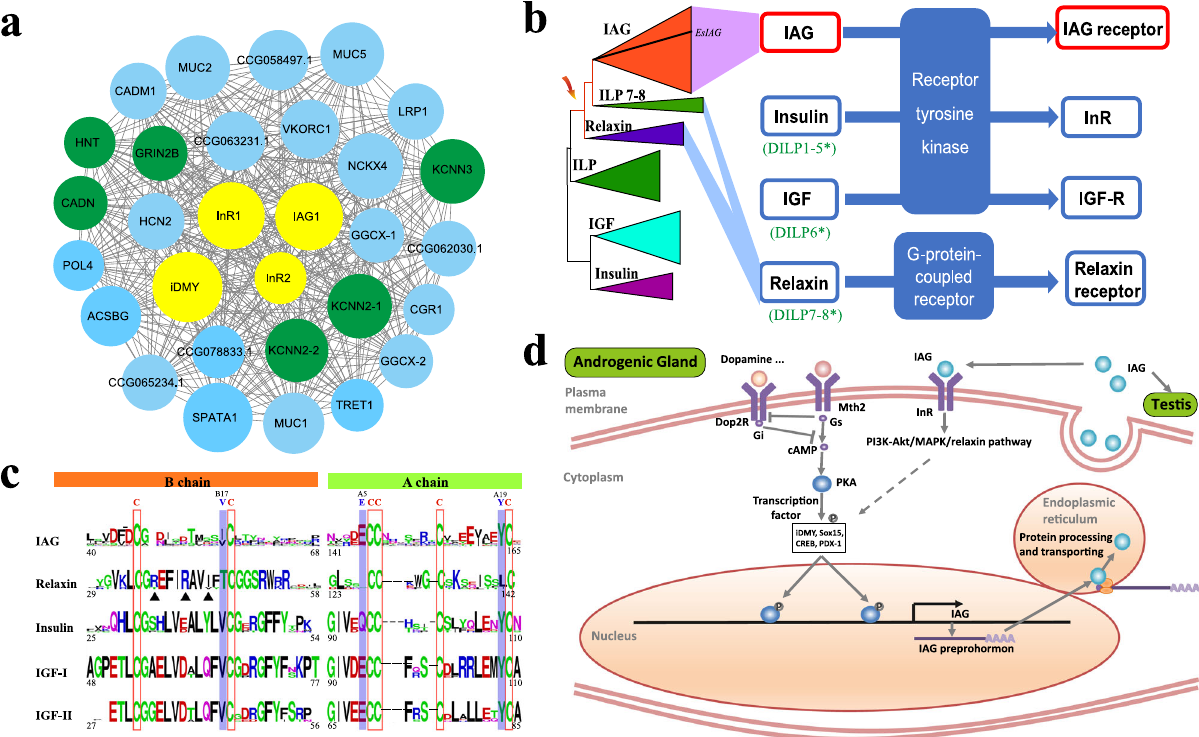
Fig. 5 The molecular regulation of AG. a The co-expression network of the AG-related module (midnightblue, see Supplementary Data 13). The midnightblue module contains 216 genes, of which 30 genes with the highest intramodular connectivity are chosen for network display. IAG-related receptors and transcription factors are labeled in yellow. The neuron or axon-related genes are labeled in green. b Insulin-like peptides and their receptors. The insulin-like peptide (ILP) is subdivided into IAG, insulins, insulin-like growth factors (IGFs) and relaxins on the basis of primary structure, processing and receptor binding preferences. c Conserved sites of crustacean IAG, and vertebrate relaxin, insulin and IGF-1 and IGF-II. The key functional sites for receptor binding are indicated by triangles. The amino acid numbers are with reference to IAG of Litopenaeus vannamei and other insulin members of human 125 . d The predicted synthesis and secretion pathway of IAG. Mth2 methuselah, PKA protein kinase A, Dop2R dopamine D2-like receptor, Gs guanine nucleotide-binding protein G(s) subunit alpha, Gi guanine nucleotide-binding protein G(i) subunit alpha, iDMY invertebrate sex-linked (Y-linked) Dmrt gene, Sox15 SRY-Box 15, CREB cyclic AMP-responsive element-binding protein, PDX-1 insulin promoter factor 1, InR insulin-like